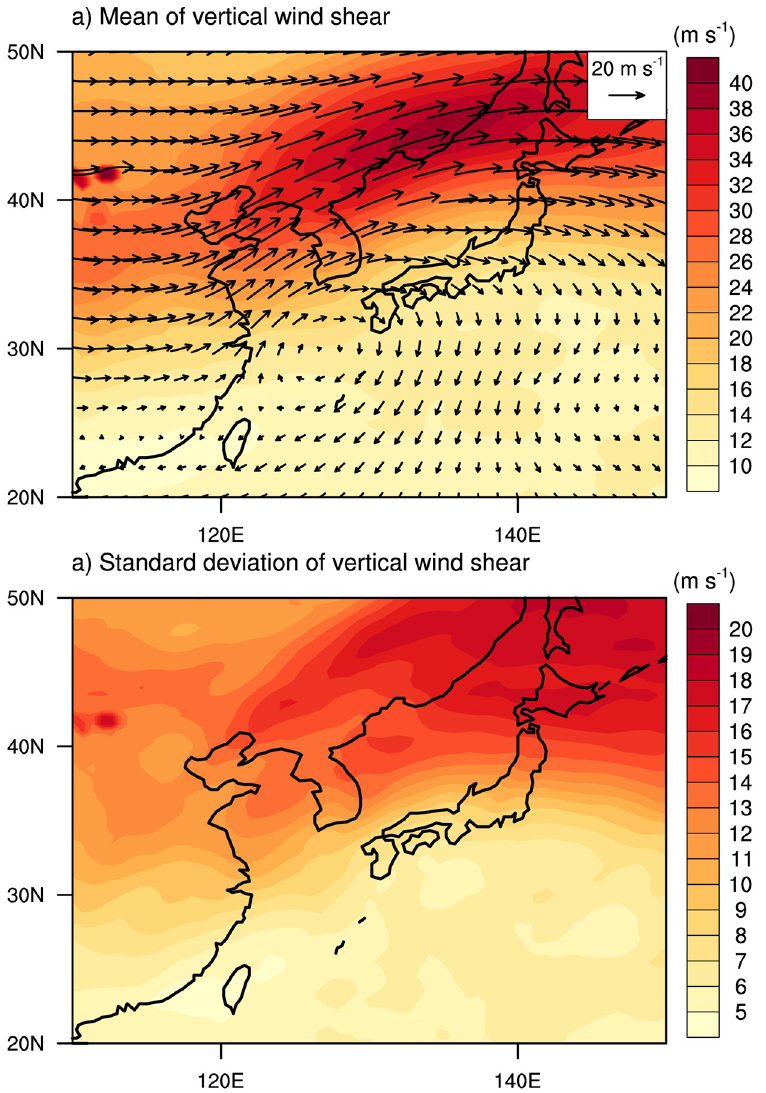
Fig 4. The (a) mean and (b) standard deviation of vertical wind shear over the East Asia region during the landfall period.